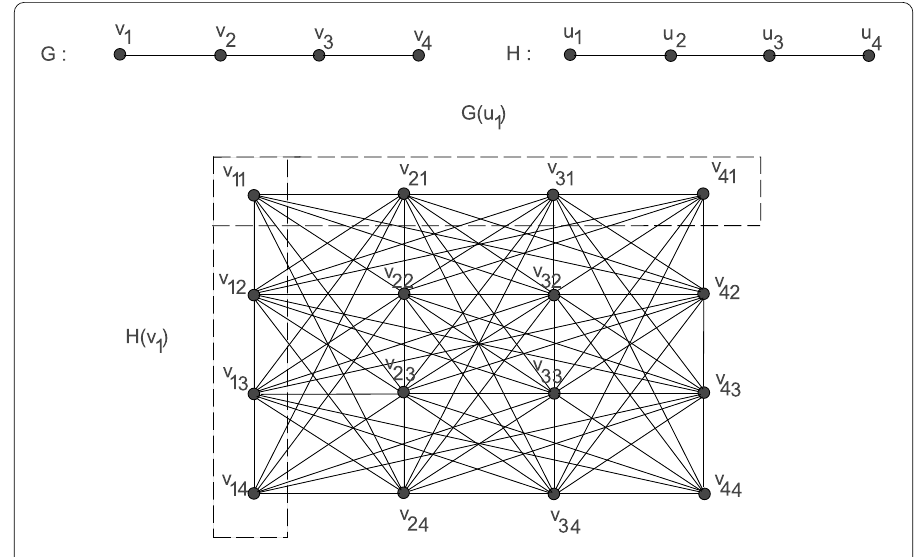
Figure 1 The co-normal product graph of P 4 and P